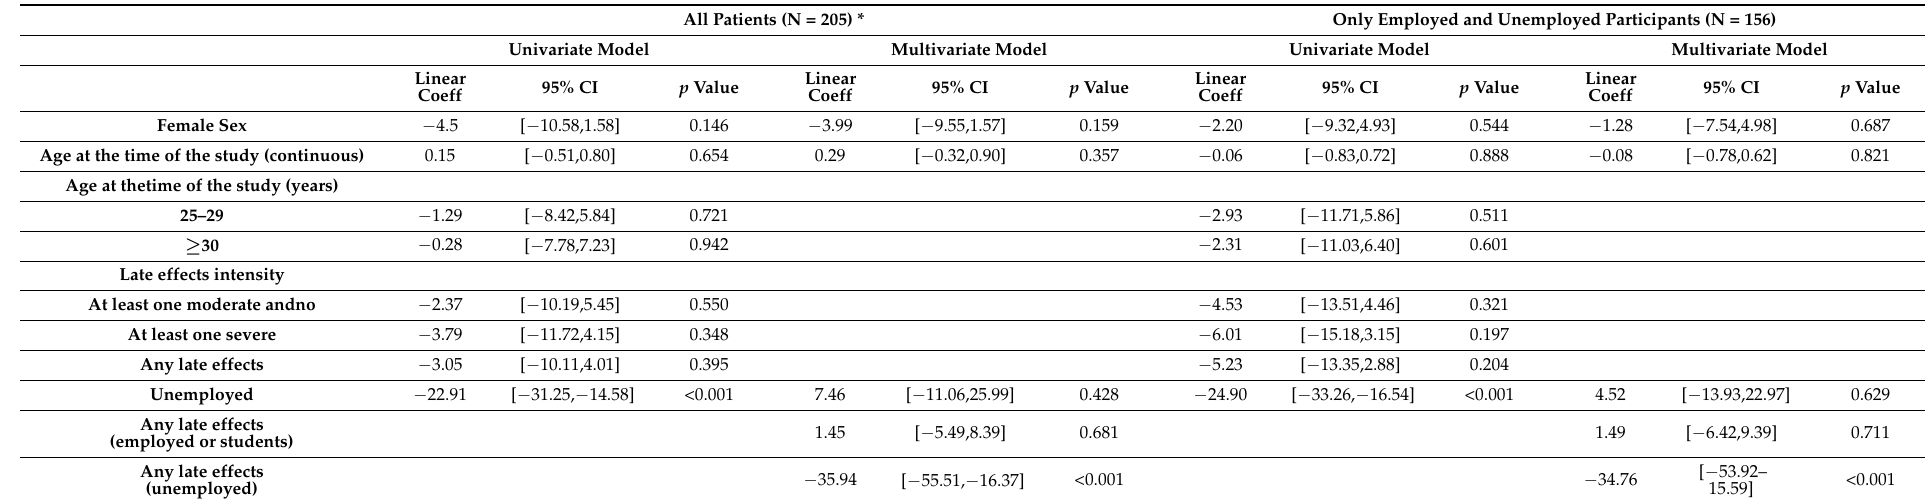
Table 5. Crude and adjusted effect on SAT-P financial satisfaction